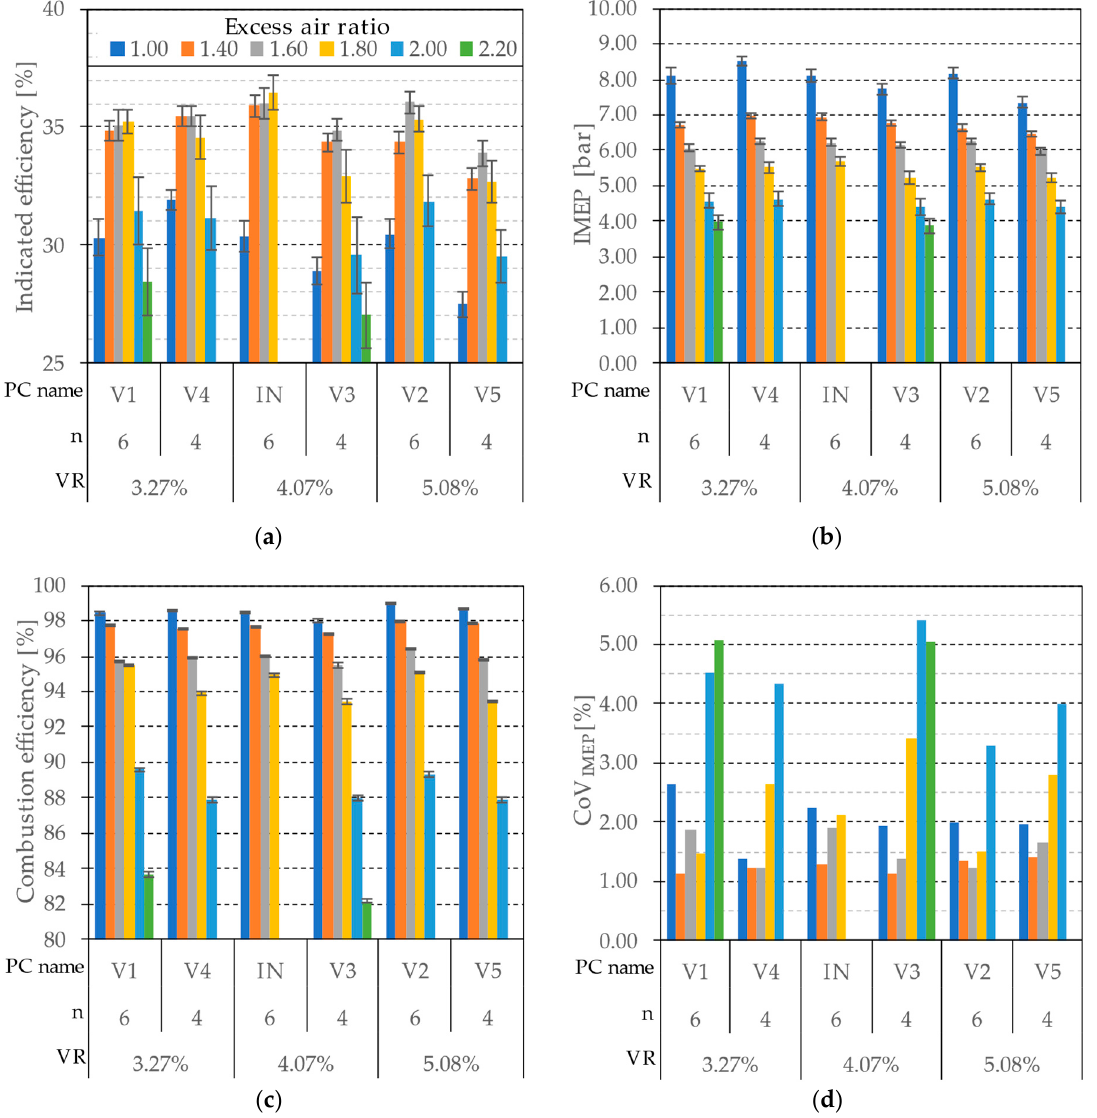
Figure 7. Influence of pre-chamber volume ratio (VR) and orifice number on engine performance: ( a ) indicated efficiency; ( b ) indicated mean effective pressure (IMEP); ( c ) combustion efficiency; and ( d ) combustion stability trough coefficient of variation of IMEP. For all PC types the orifice area to volume ratio OA = 0.003 mm − 1 .